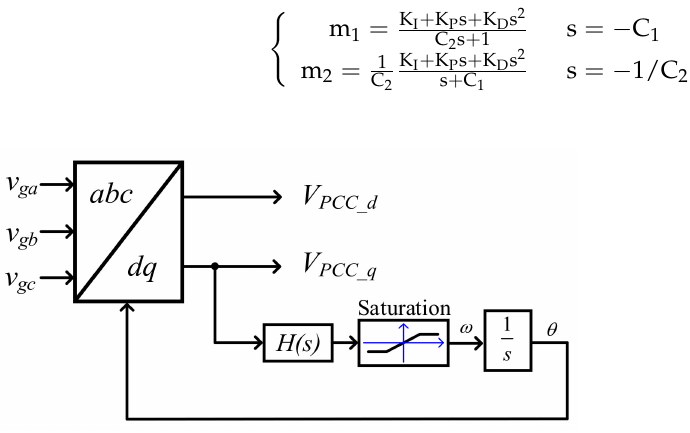
Figure 6. Phase-locked loop (PLL) block diagram.